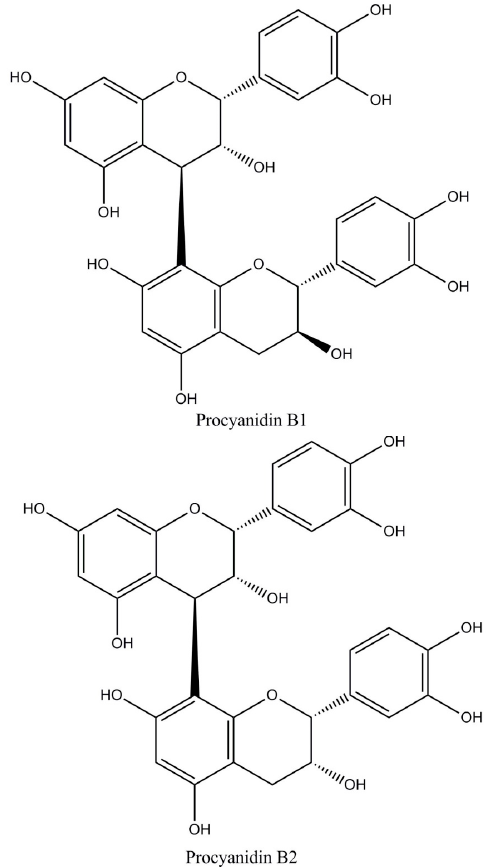
Figure 2. Major proanthocyanidins-dimers in cocoa.